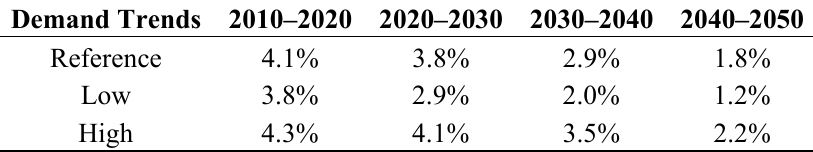
Table 6. Growth rates for residential energy demand in scenarios.